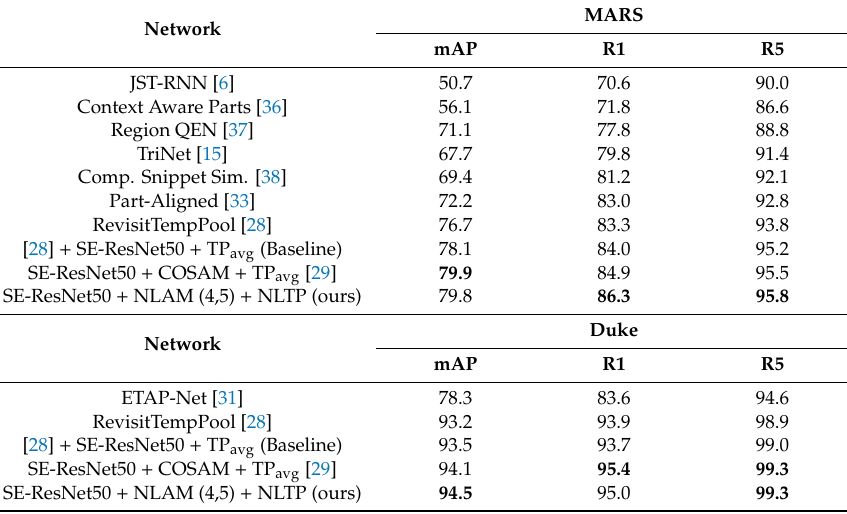
Table 7. Comparison of our model with our baseline and a series of state-of-the-art models on the two datasets MARS and DukeMTMCVideoReID. TP avg = average Temporal Pooling. NLAM (4,5) means to add the NLAM layer after the fourth and fifth CNN